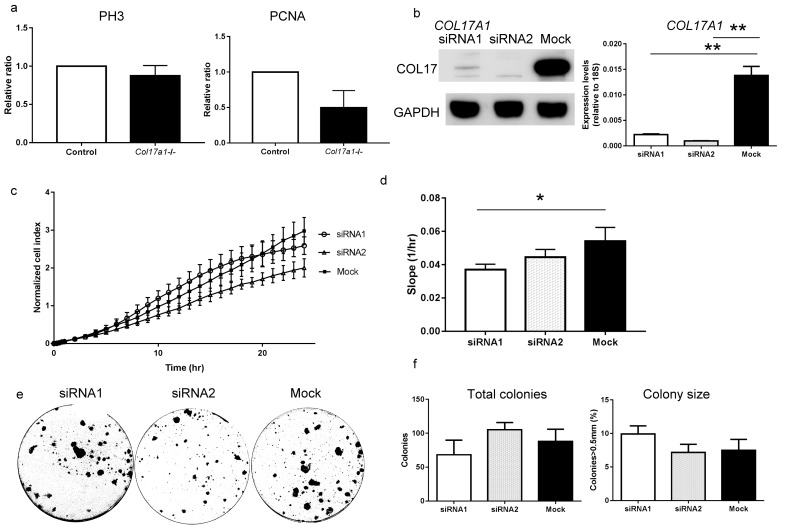
Proliferative ability of the back skin IFE from Col17a1−/− mice and NHEKs treated with COL17A1 siRNAs.(a) PH3- and PCNA-positive cells in the Col17a1−/− back skin (n = 4 for Col17a1−/−; n = 5 for control). (b) COL17A1 knockdown efficiency in NHEKs. The left panel shows COL17 immunoblotting of lysates from NHEKs treated with siRNAs. The right panel shows the qRT-PCR results of COL17A1 (n = 3). (c–d) Cell proliferation curve (c) and slope (d) of NHEKs treated with siRNAs (n = 3). (e–f) Colony formation assay of NHEKs treated with siRNAs. Gross appearance (e), total colony number (f-left) and the percentage of colonies that were larger than 0.5 mm (f-right) (n = 3). The data are presented as the means±SE. *0.01<p<0.05, **0.001<p<0.01, Student’s t-tests.